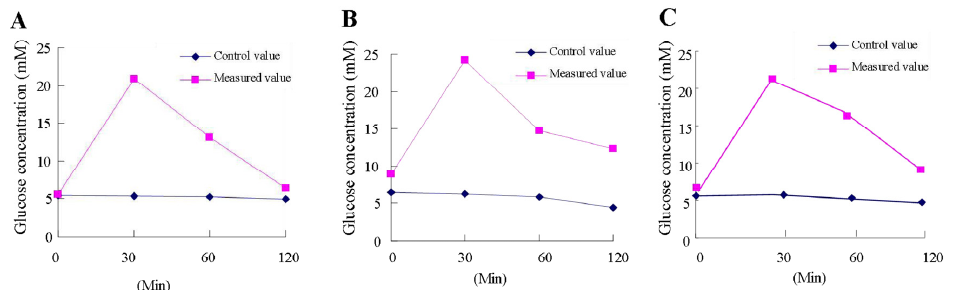
Figure 1. Octacosanol could enhance the glucose tolerance in the high-fat diet mice. ( A ) Con group; ( B ) HFD group; and ( C ) HFD+Oct group.